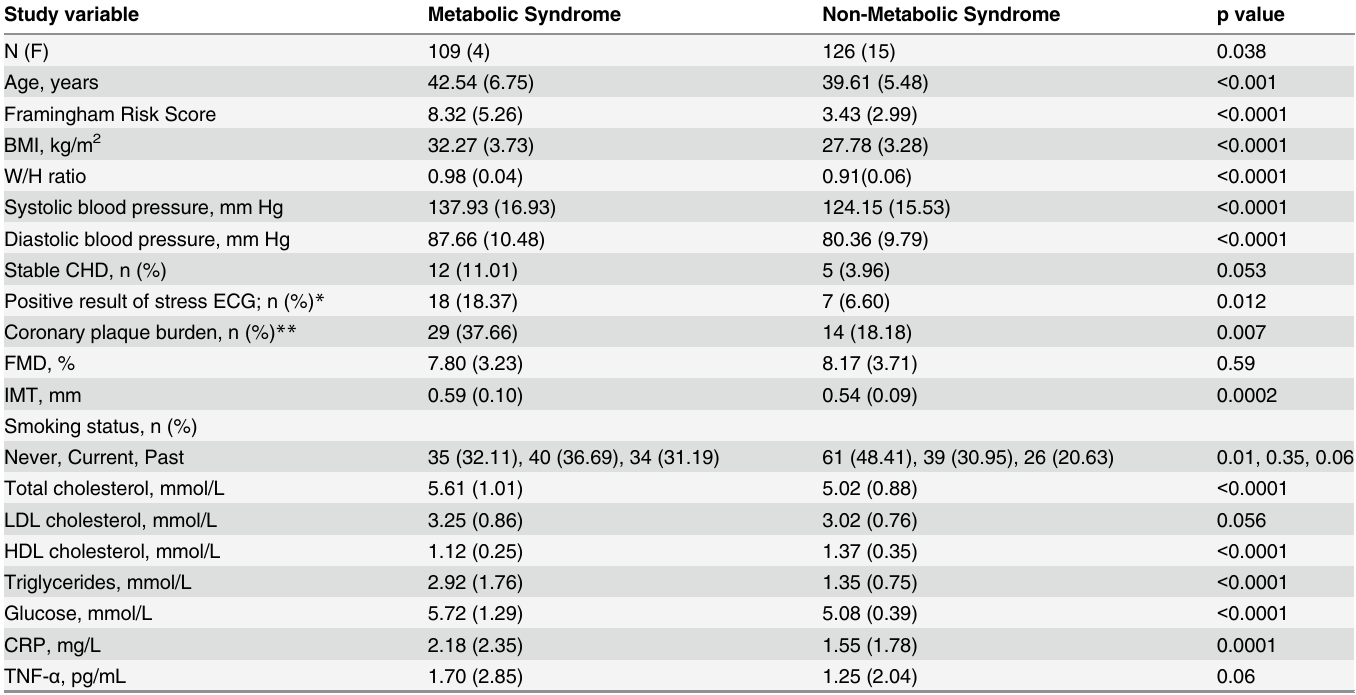
Table 2. Characteristics of the study subjects stratified by metabolic syndrome